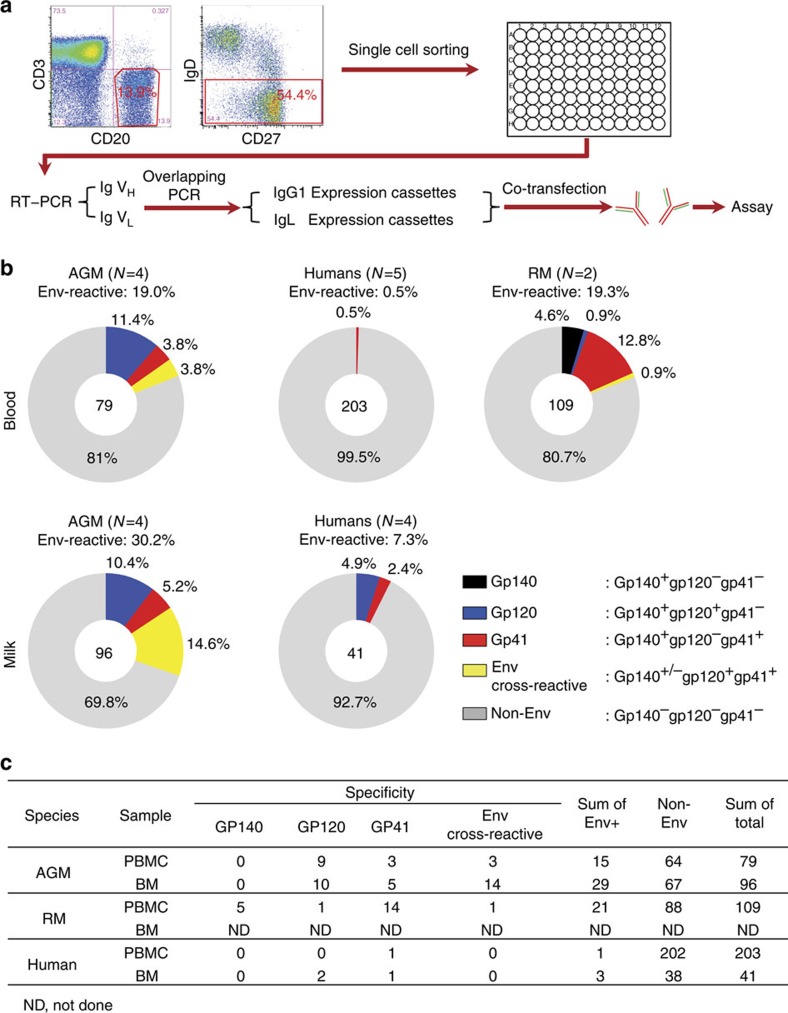
High proportion of Env-reactive memory B cells in chronically SIV-infected AGMs compared with that in RMs and humans.Env reactivity of monoclonal antibodies (mAbs) isolated from single-cell sorted memory B cells of chronically SIV/HIV-infected AGM, RM and human blood and breast milk. (a) Schematic presentation of mAb isolation process. Memory B cells were sorted into 96-well PCR plates as CD3−CD20+IgD−CD27all for AGM and RM samples and CD3−CD19+IgD−CD27all for human samples. V(D)J gene segments were then isolated from single memory B cell by RT reaction followed by nested PCR and assembled into linear Ig gene expression cassettes of heavy and light chain for the production of recombinant mAbs. (b) Total numbers of mAbs isolated from blood of AGMs (N=4), RMs (N=2) and humans (N=5) are indicated at the centre of each pie chart. Percentages of mAb binding to gp140, gp120, gp41, or multiple antigens are indicated in different colours. AGM blood mAbs (19.0%) were SIV Env-reactive, which was significantly higher than those isolated from human blood (0.5%, P<0.0001, Fisher's exact), but not different from those isolated from RM blood (19.3%, P=1.0, Fisher's exact). Yet, the percentage of gp120-specific mAbs in AGM blood (11.4%) was significantly higher than that in RM (0.9%, P=0.001, Fisher's exact). Of 96 mAbs isolated in AGM breast milk (N=4), 30.2% were SIV Env-reactive, which was significantly higher than that in human breast milk (N=4, 7.3%, P=0.01, Fisher's exact). The proportion of gp120-specific mAbs isolated from milk memory B cells was not significantly different in AGM (10.4%) and human breast milk (4.9%, P=0.7, Fisher's exact). Gp140 indicates mAbs that bound gp140 only; Gp120 indicates mAbs that bound gp120, bound or not bound gp140; gp41 indicates mAbs that bound gp41, bound or not bound gp140; Env cross-reactive indicates mAbs that bound gp140, gp120 and gp41; or gp120 and gp41; Non-Env indicates mAbs that did not bind Env protein tested. (c) Summary of Env-binding distribution of mAbs isolated from SIV-infected AGMs, RMs and HIV-infected human subjects.